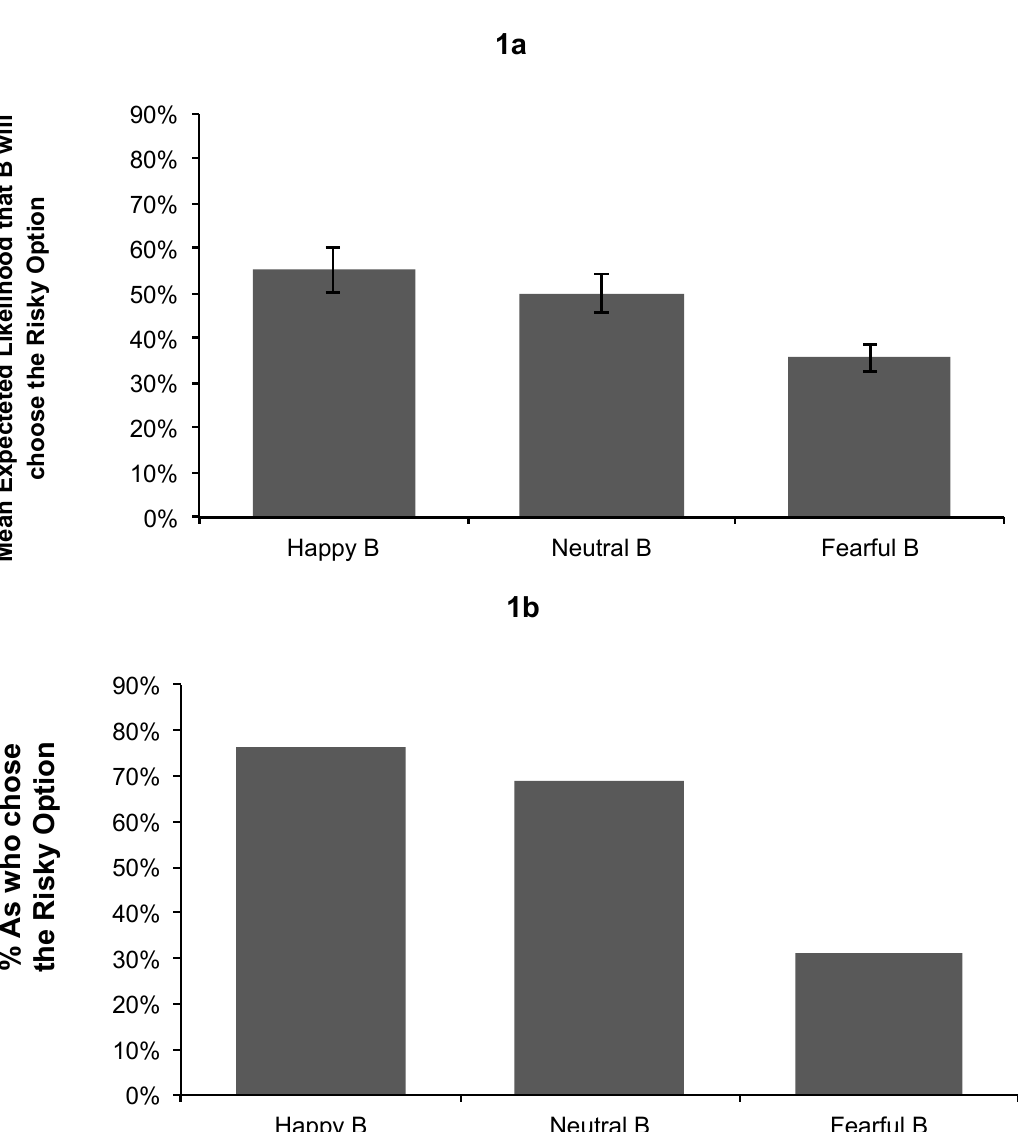
Figure 1. Expectations that Bs would choose the Risky Option ( a ) and the proportion of As choosing the Risky option ( b ) by experimental condition. Error bars represent standard errors of the means.